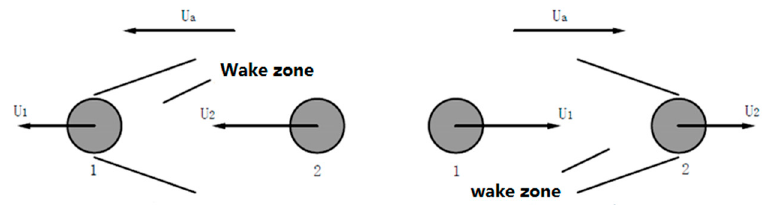
Figure 4. Schematic of acoustic wake effect.